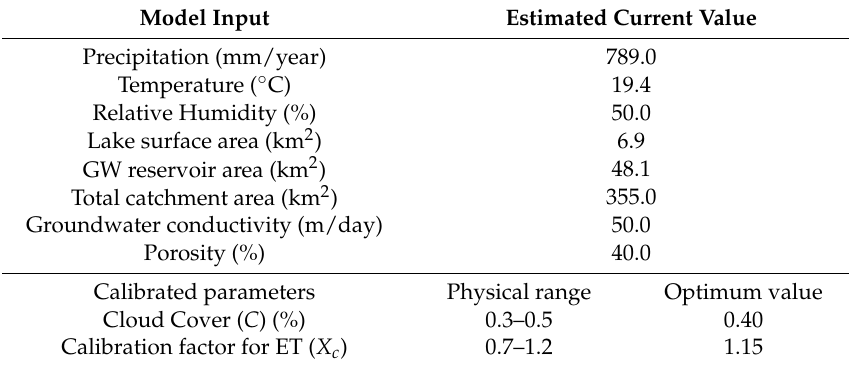
Table 1. Summary of model input variables, physically plausible range of parameters used in the calibration, and resulting optimum parameter value after calibration to observations.